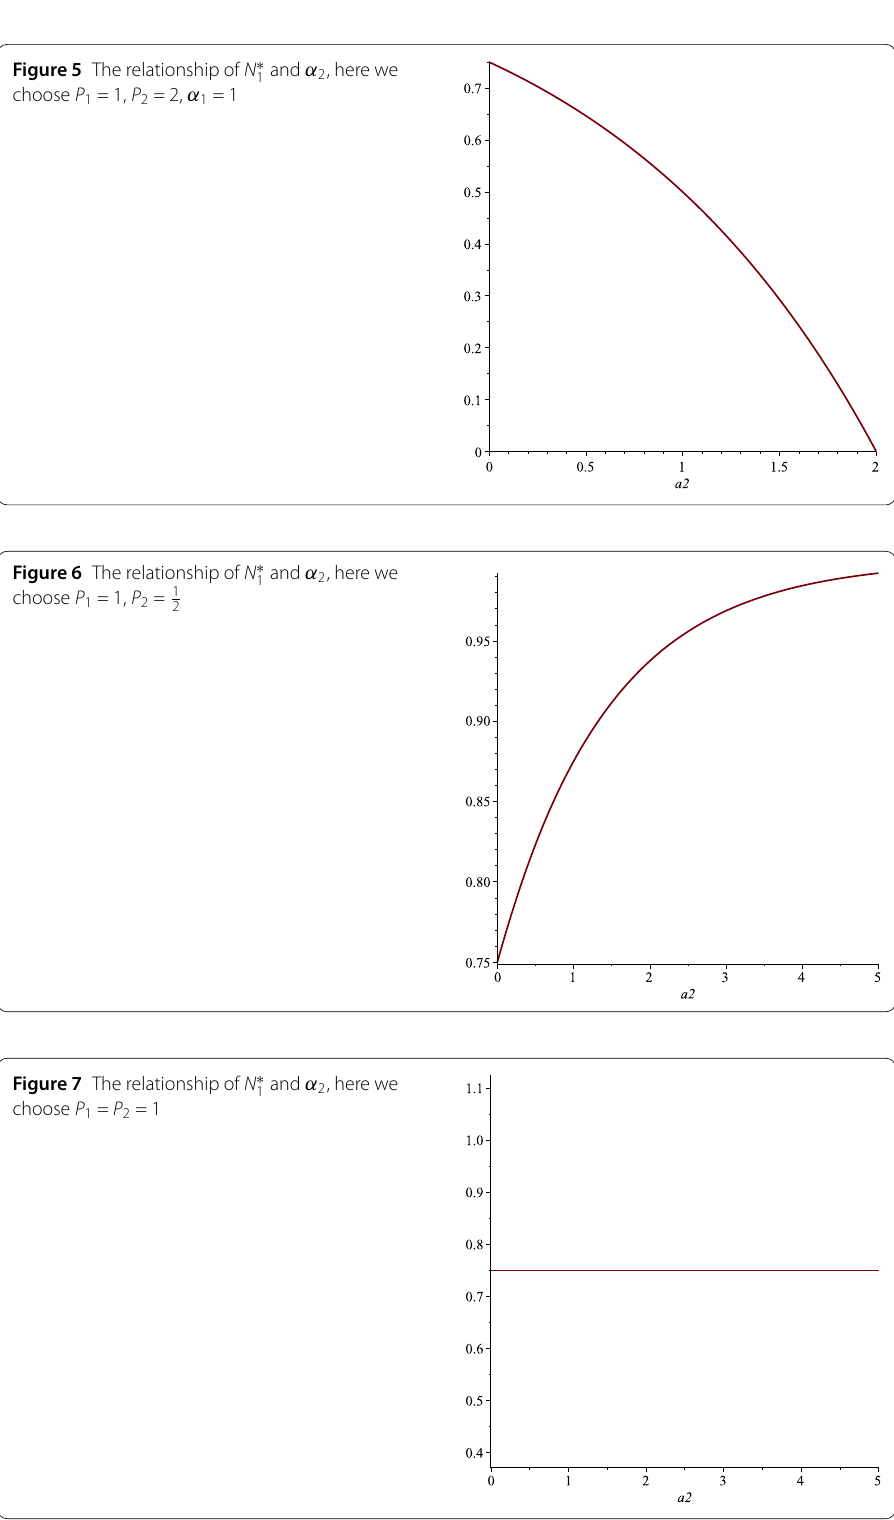
Figure 7 The relationship of N ∗ 1 and α 2 , here we choose